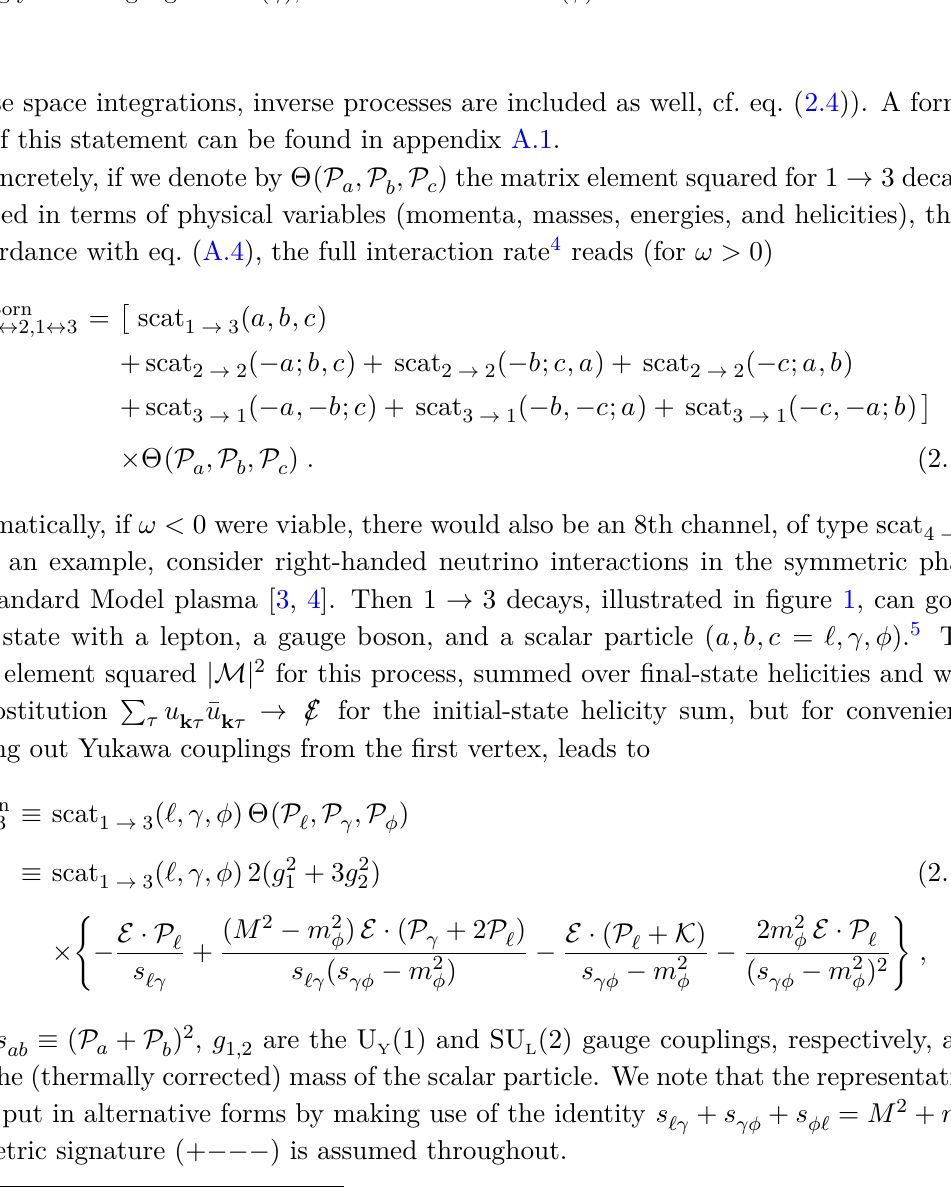
Figure 1 . As an example of amplitudes needed for determining the basic input for our algorithm, we show the 1 → 2 process leading to Γ Born leading to eq. (2.13). Double lines correspond to right-handed neutrinos; arrowed lined to leptons ( ‘ ); wiggly lines to gauge fields ( γ ); dashed lines to scalars ( φ